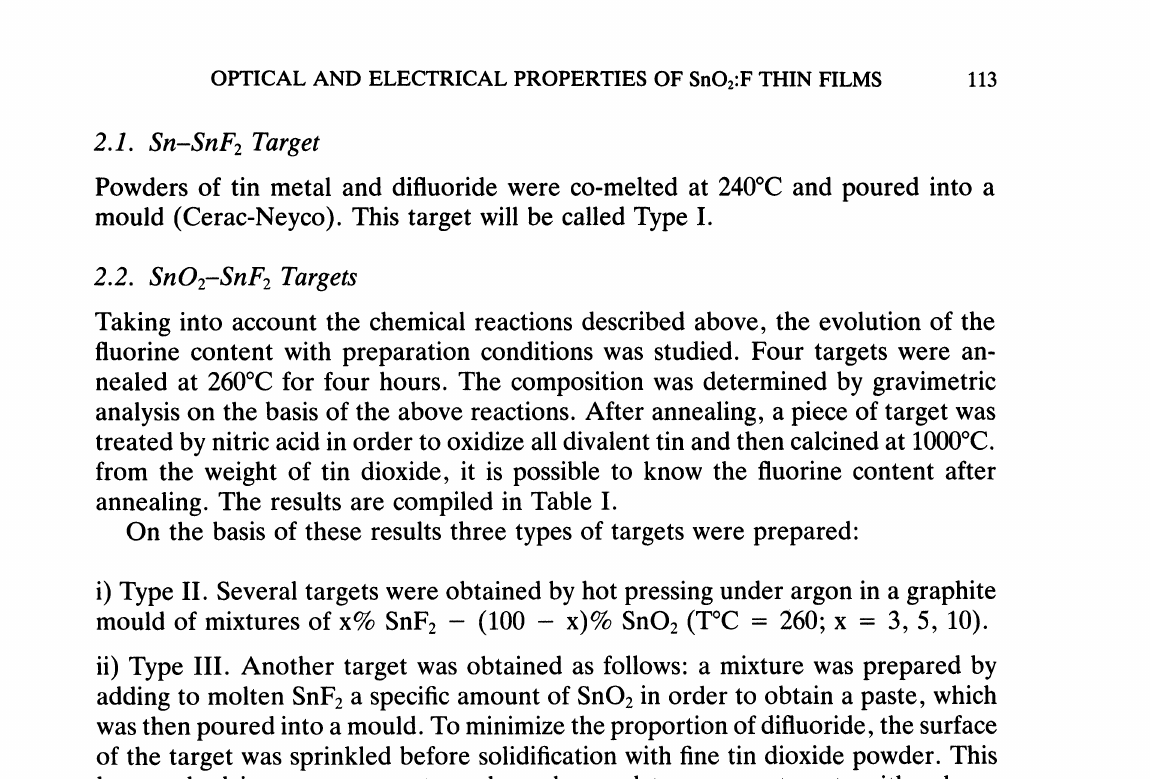
Evolution of target composition after annealing at 260C during four